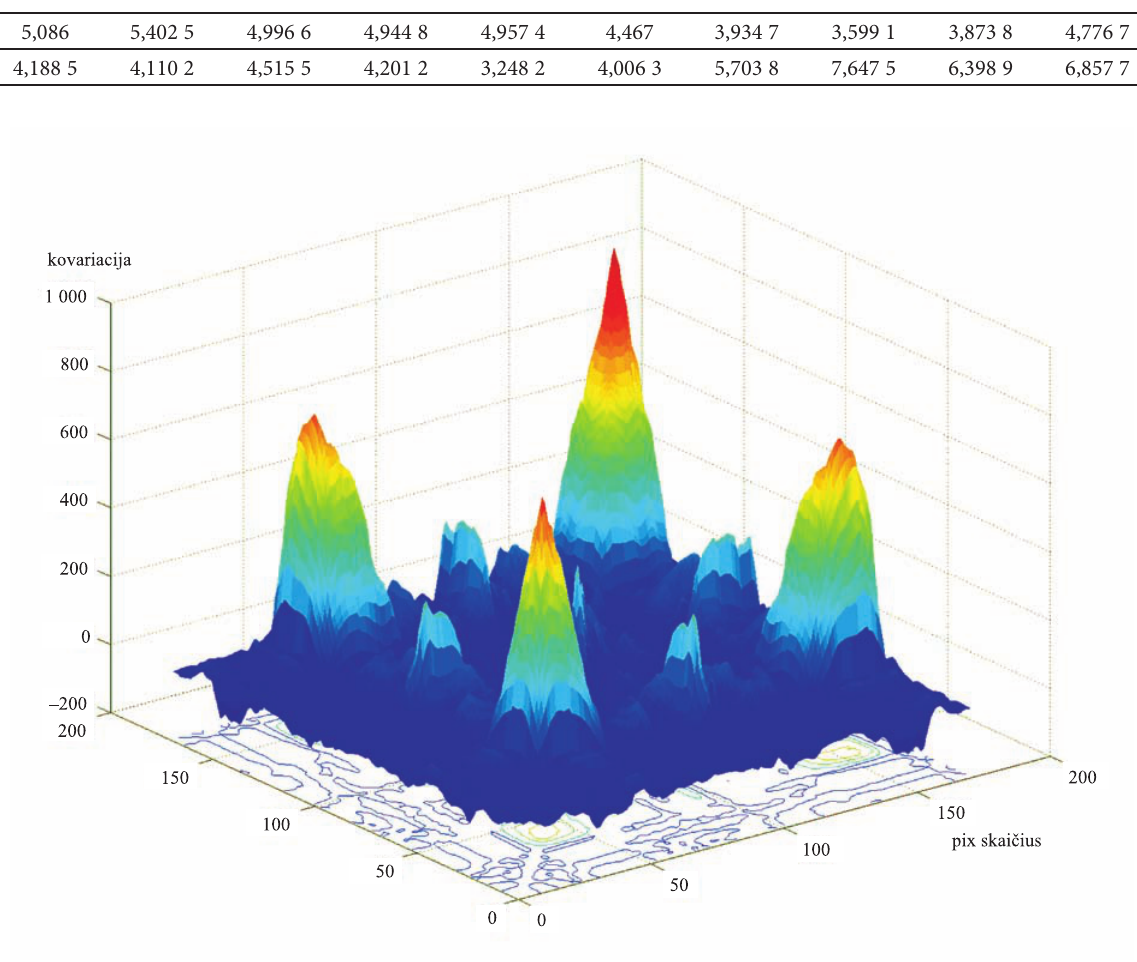
Lentelė. 2 variantų analizės standartinių nuokrypių įverčių (pikseliais) vektoriaus dalis Table. Part of a vector of the standard deviations of the 2 analysis variants, pixels